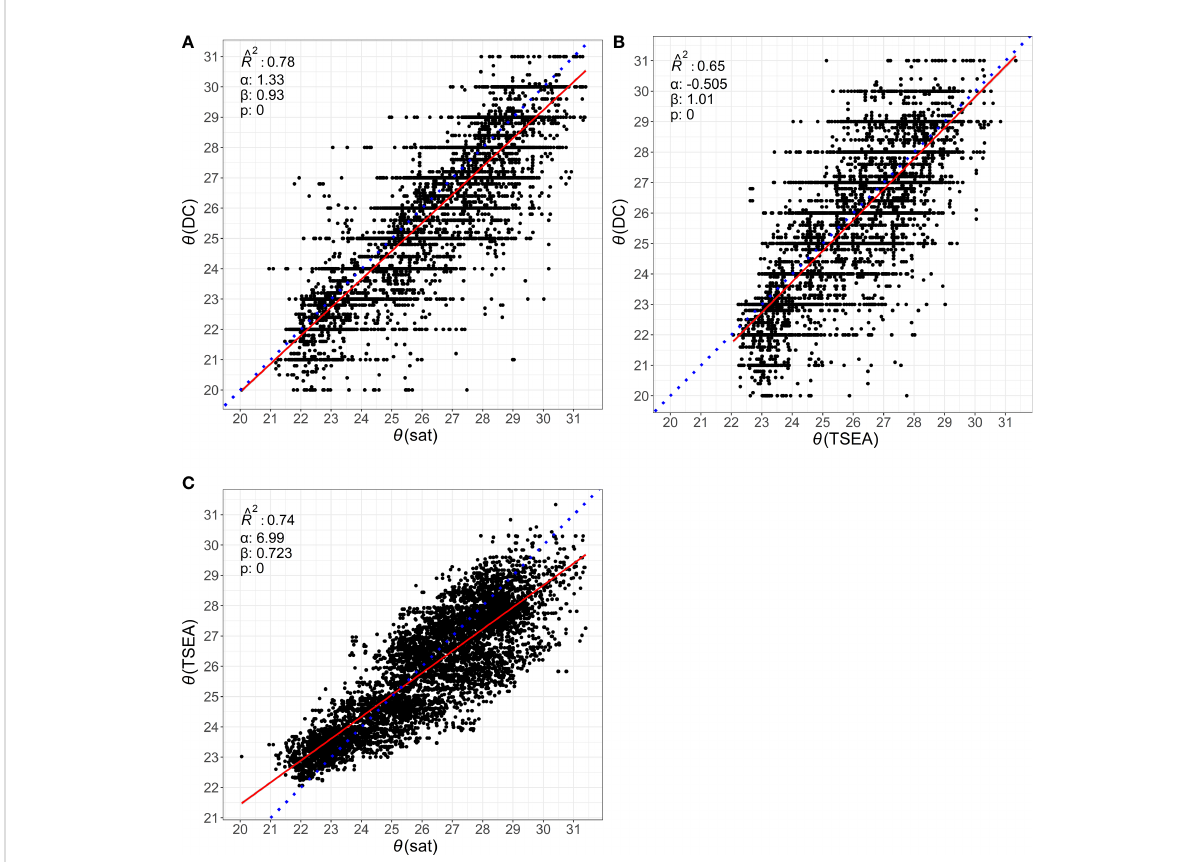
October and April and in June (Figure 5C). Mean monthly temperatures for all data sources show seasonal patterns consistent with those seen in the regional climatology. Seasonal patterns can be seen in overall mean monthly data for each data source, and also individual years (Figure 6) We also explored bias on a weekly basis, with the same patterns of relative differences observed (See supporting information).